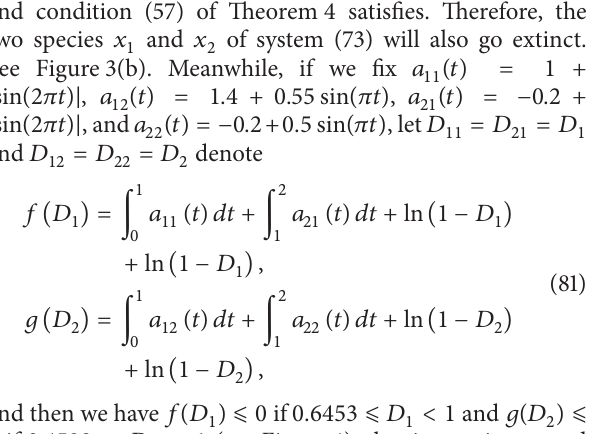
= 1 and 𝑥 = 2 10 20